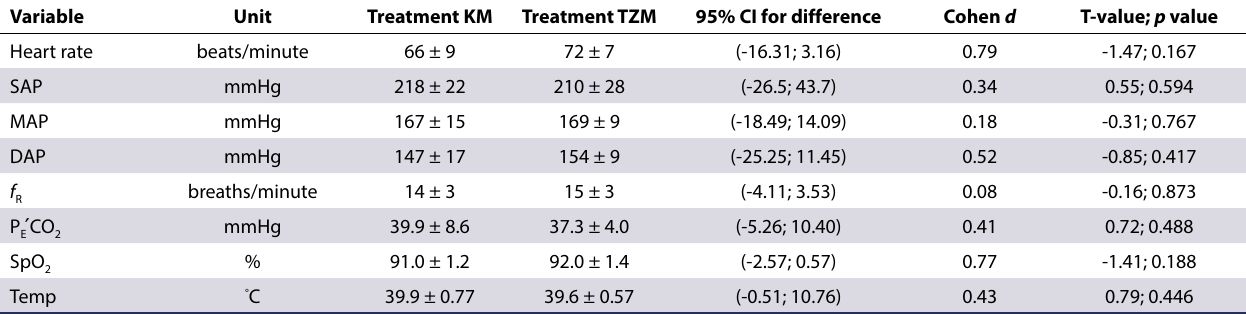
Table I: Physiological variables of seven cheetahs ( Acinonyx jubatus ) 15 minutes after being immobilised with ketamine-medetomidine (KM) and tiletamine/zolazepam-medetomidine (TZM) once, one year apart. Parameters are reported as mean ± standard deviation (SD). Variable